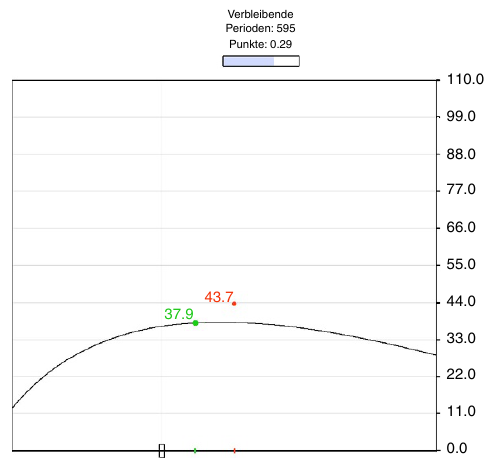
Figure 1 | Interface in the Info treatment. The subject chooses her action on the horizontal axis via a slider. The green and red dots represent a subject’s, respectively his or her partner’s, earnings in the preceding period. The black line shows the potential payoffs in the preceding period. On the top of the interface, the subjects see the number of remaining periods, the amount of points they earned and how much time they have left to decide via a progress bar. The interface in NoInfo is exactly the same except for the black curve of potential payoffs. Note that, in the experiment, the x axis is intentionally left unlabelled to avoid giving the subjects any cues on how to behave. The y axis shows the payoffs in